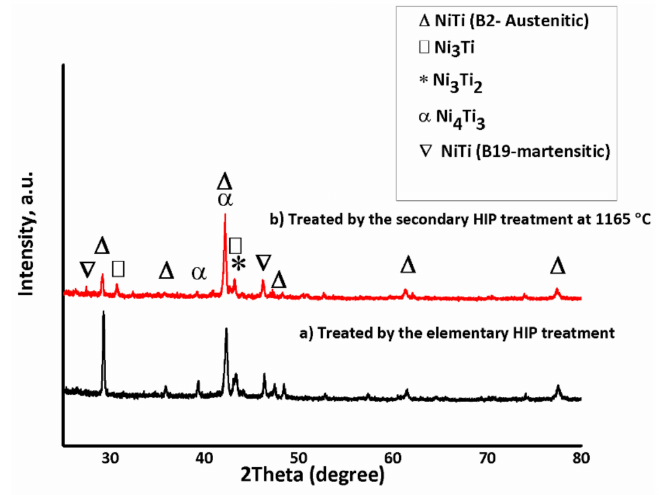
Figure 8. XRD patterns of (a) 60NiTi samples processed by elementary HIP treatments, from parts printed by set 4 having an energy input of 39.68 J/mm 3 and (b) the same 60NiTi samples treated by the secondary HIP treatment conducted at 1165 ◦ C for 1 h and under an applied pressure of 180 MPa. In terms of existing flaws such as cracks and pores, the obtained microstructures, despite being compositionally very different as compared to their as-printed conditions (Figures 4–6), were very similar to the as-printed ones. As presented in Figure 9, the characteristics of flaws existing in the microstructure of each HIP-treated part were similar to its as-printed condition. In essence, cracks and pores were present in the microstructures of both 58NiTi and 60NiTi parts. The microstructures of parts obtained from those printed by set 1 were dominated by large pores; the ones processed from those printed by set 4, with cracks.